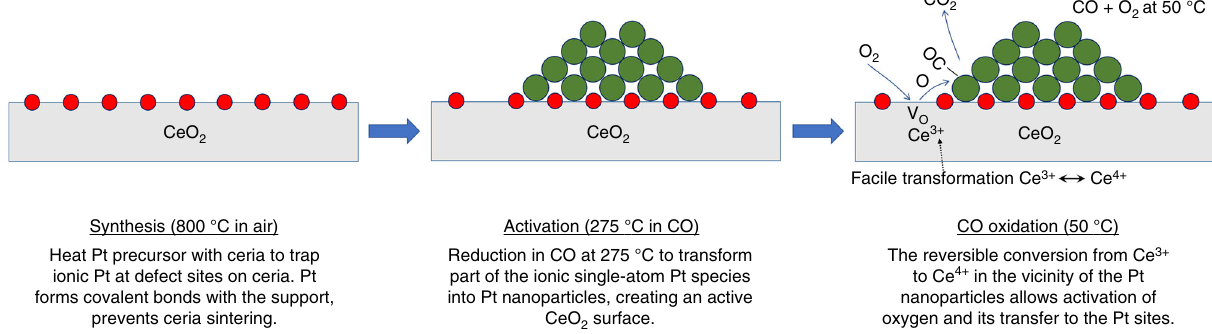
surface.Heat Pt precursor with ceria to trap in CO at 275 °C to transform ionic Pt at defect sites on ceria. Pt part of the ionic single-atom Pt species forms covalent bonds with the support, into Pt nanoparticles, creating an active prevents ceria sintering. CeO 2 Fig. 7 Synthesis of single-atom Pt/CeO 2 with improved reducibility and its transformation into an active catalyst. The Pt/CeO 2 single-atom catalyst is reduced and forms Pt nanoparticles. This active state of the catalyst readily provides oxygen to react with CO adsorbed on Pt nanoparticles, preventing CO poisoning. Red: ionic Pt, green: metallic